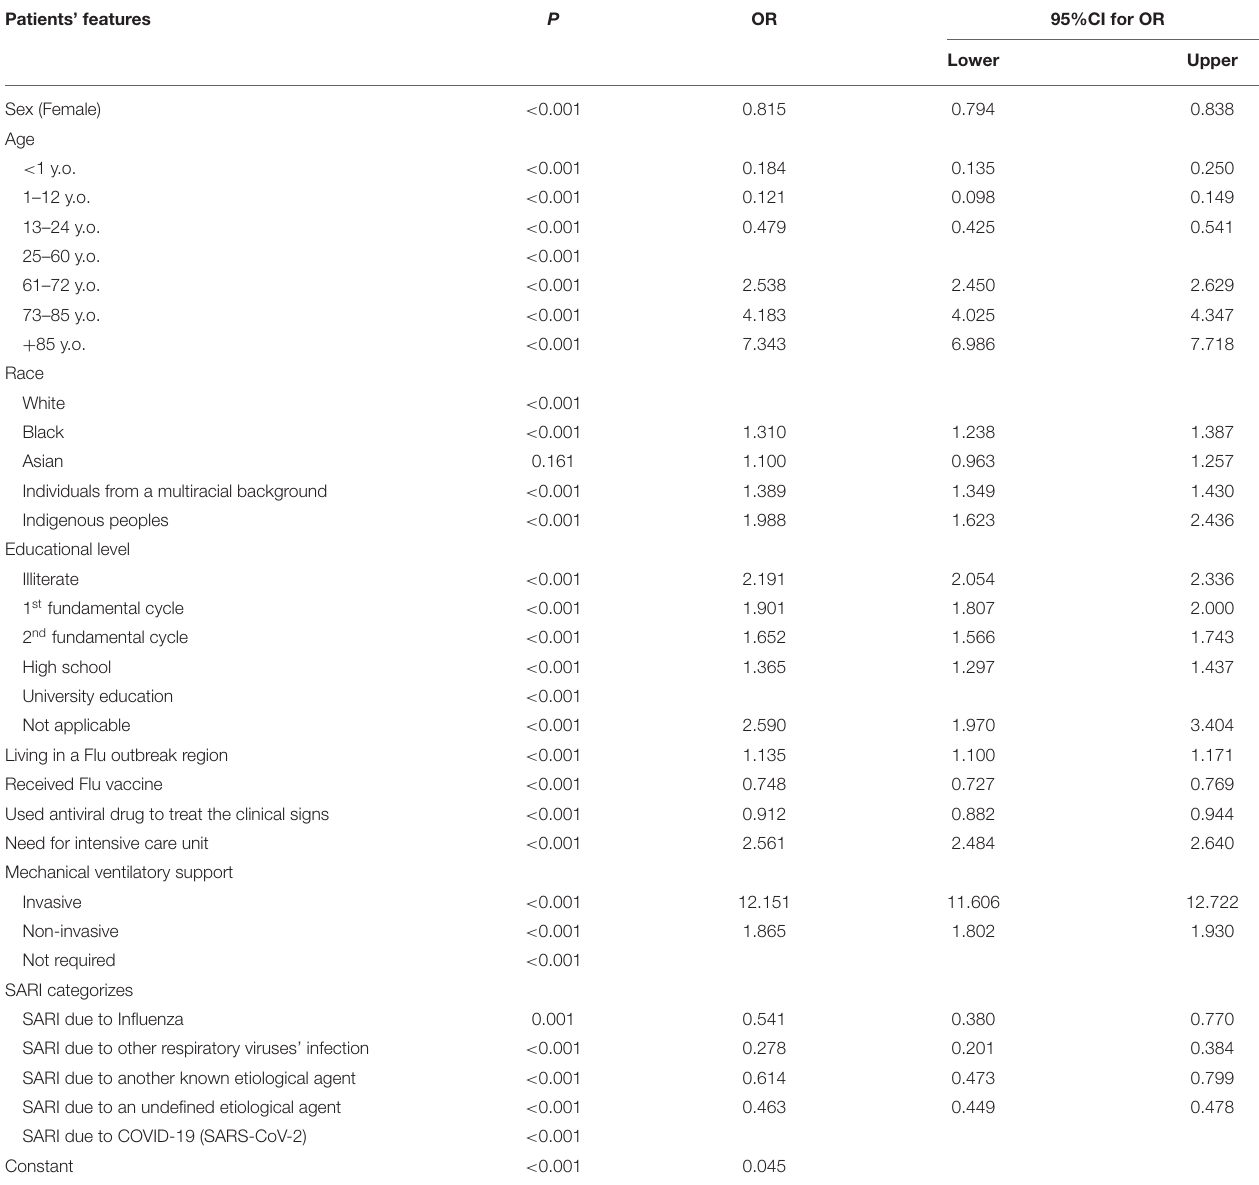
TABLE 5 | Multivariate analysis using Binary Logistic Regression to predict the chance of death and the features of the hospitalized patients due to severe acute respiratory infection (SARI) in Brazil during the Coronavirus Disease (COVID)-19 pandemic. Patients’